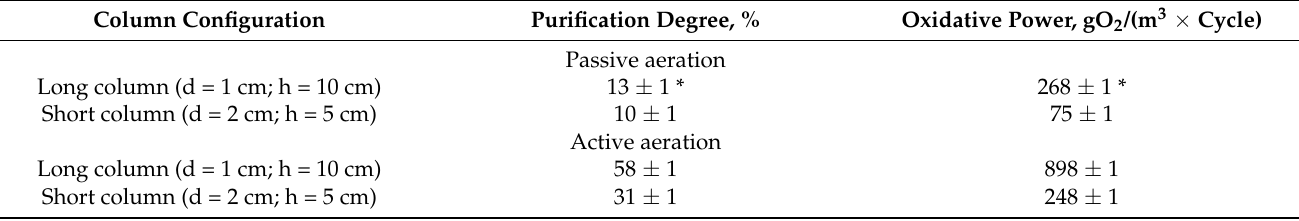
Table 4. Characteristics of the biofilter with the loading bed material made of methylotrophic yeast encapsulated in STP EG -composite under natural (passive) and active aeration.